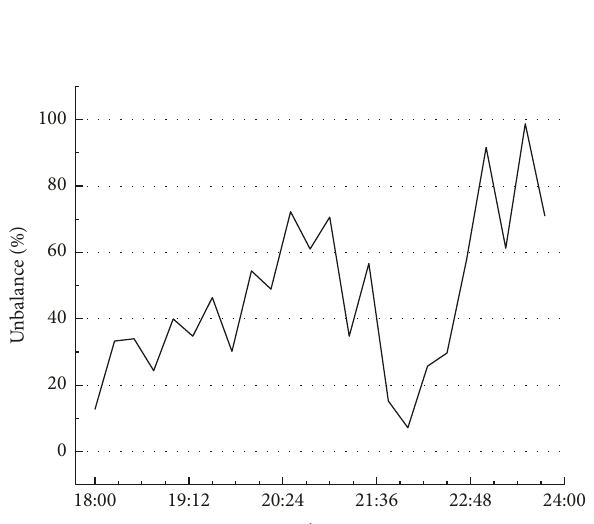
Figure 2: Three-phase current.